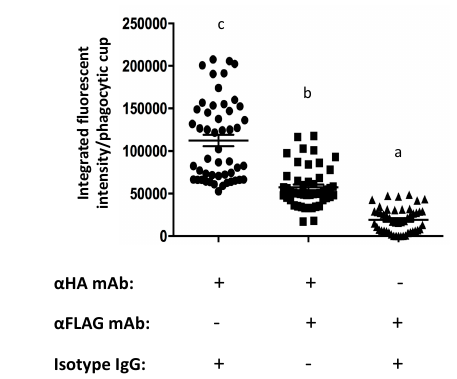
Figure 4. Confocal microscopic analysis of phosphotyrosine staining levels within phagocytic cups. 2.6b ITAM CYT /1.1b WT CYT co-expressing AD293 cells ( A ) were grown on coverslips and incubated with 4.5 µm non-fluorescent (NF) beads opsonized with α -HA mAb and mouse isotype IgG1. After 8 min of incubation at 37 °C, cells were fixed with 4% PFA for 10 min and non-phagocytosed beads were stained using Alexa 647-conjugated goat- α -mouse secondary pAb (red). Cells were then permeabilized and specifically stained for intracellular phosphotyrosine molecules by first incubating them with a rabbit α -phosphotyrosine mAb and then with a secondary goat- α -rabbit pAb conjugated to Alexa 488 (green). Z-stack images were obtained at a magnification of 63X using a Zeiss LSM 710 scanning confocal microscope. Representative images from z-stack acquisitions are shown as images with phosphotyrosine (green) staining, surface-exposed bead (red) staining, and merged-fluorescence images or brightfield-fluorescence merged images. Yellow arrowheads show the positions of representative phagocytic cups and the target bead of interest is indicated by an asterisk (*). ( B ) Qualitative analysis of bead and phosphotyrosine molecule staining intensities was performed using ImageJ software (NIH, Bathesda, Maryland, DC, USA) by calculating the MFI (y-axis) of the bead (red line) and phosphotyrosine molecule staining (green line) across the dash arrowed line. ( C ) To further quantify the phosphotyrosine molecules recruited to phagocytic cups under different activation conditions, 2.6b ITAM CYT /1.1b WT CYT co-expressing cells were incubated with NF beads opsonized with indicated mAbs (’+’ and ‘ − ’ indicate the presence and absence of corresponding mAbs, respectively). For analyses, a region of interest (ROI, indicated by dashed circles) was first drawn that includes phagocytic cups so phosphotyrosine signal intensities in this area could be calculated. As summarized in ( D ), at least 50 phagocytic cups from three independent experiments were pooled and the data is represented as mean integrated fluorescent intensity ± SEM. Differing letters indicate statistical significance ( p ≤ 0.05) between means. Experimental groups were compared using a one-way ANOVA, followed by the Tukey test using Prism 6 software (GraphPad Software, La Jolla, CA, USA).